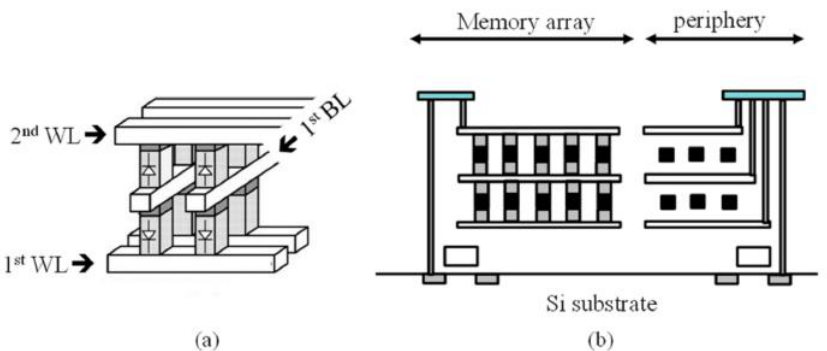
Figure 1. A structure of the crosspoint non-volatile memory array ( a ) and cross-sectional view of the chip where CMOS is fabricated under the array ( b